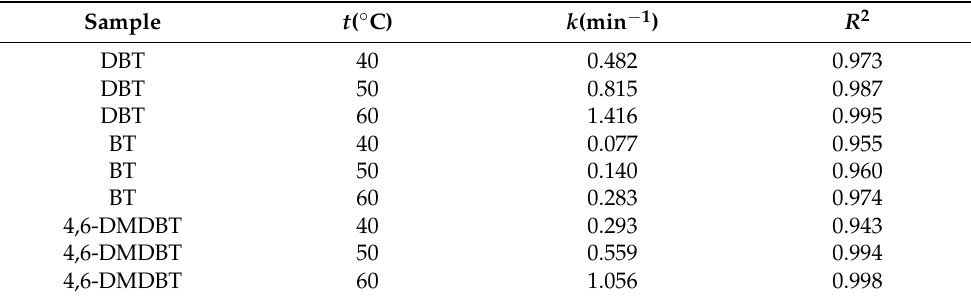
Table 1. The reaction rate constant ( k ) and correlation coefficient ( R 2 ) for the oxidation reactions of DBT, BT, and 4,6-DMDBT at different